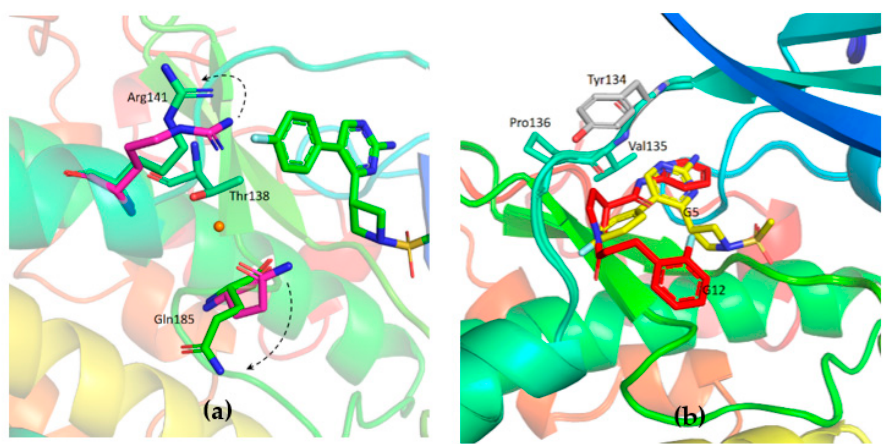
Figure 8. ( a ) Electron density corresponding to G12 contoured at 1.2 Sigma; ( b ) Hydrogen bonding interaction of G12 with the residues of hinge region; ( c ) Water-mediated hydrogen bond between carboxamide oxygen of G12 and Gln185; PDB 7U2Z.